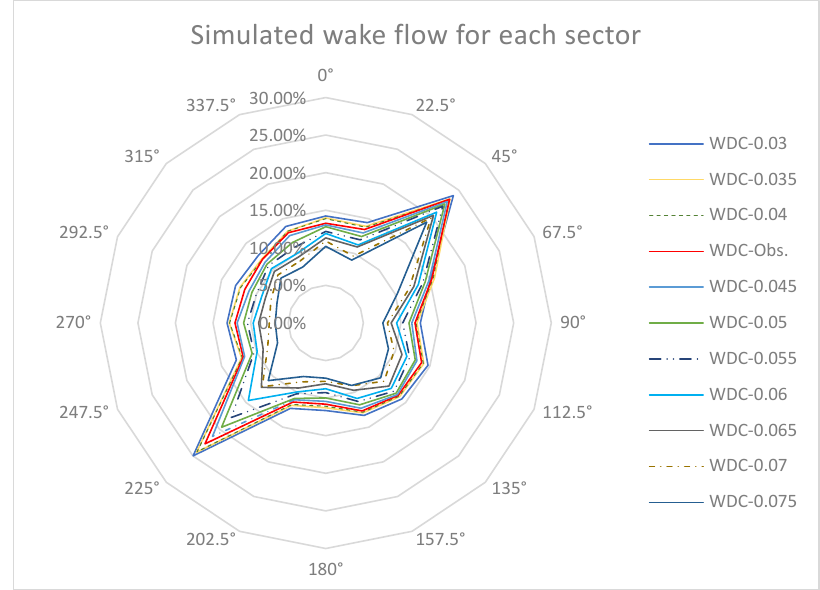
Figure 11. simulated wake loss for each sector. The output of the first three turbines drops rapidly and then flattens out, as shown in Figure 4. When the wake decay constant is between 0.03 and 0.04, the simulated power generation is closer to the actual power generation. Figure 12 shows that when the wake decay constant is set to 0.04, the simulation result is the closest to the actual output (Figure 12, Obs.), with an error of 1.02%.